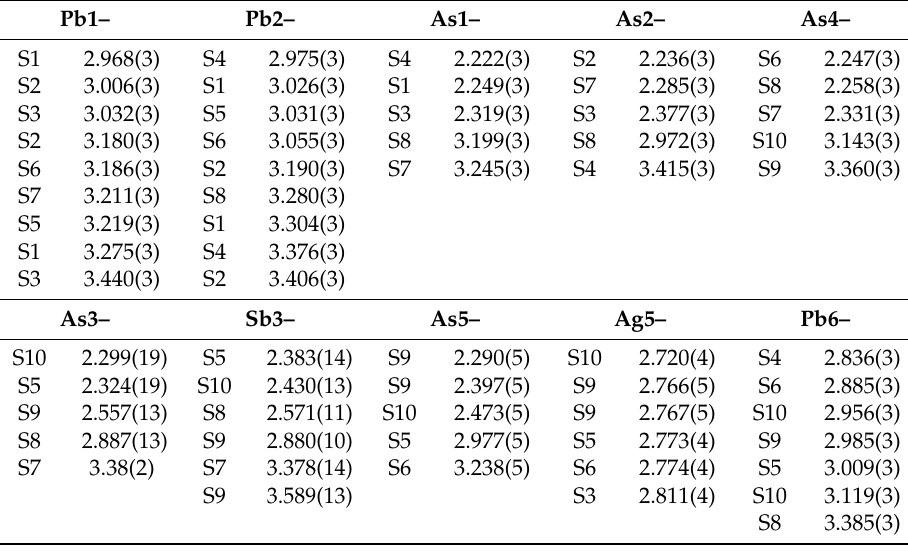
Table 9. Bond lengths in sample rath1 (Tl-poorest sample, with 0.16 wt% Tl).